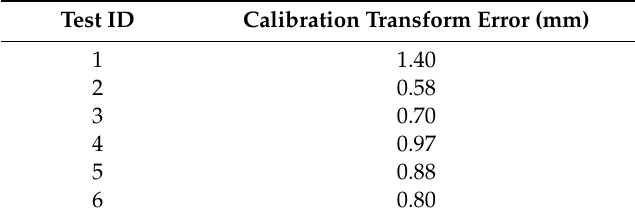
Table 1. Performance results of calibration procedure